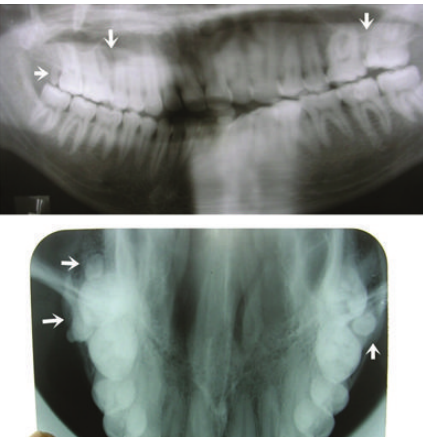
Figure 3: IOPA showing the paramolars and microdontic third molar and the surgical specimen of